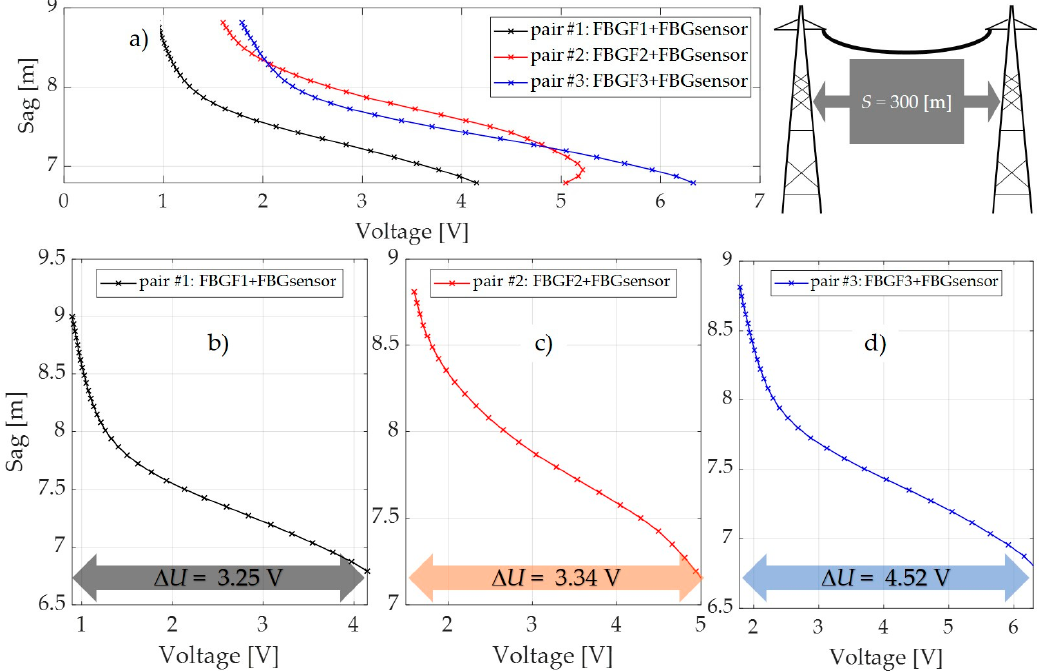
Figure 23. The results of the power line wire sag as a function of the photodetector measured voltages for power line # 3: ( a ) the sag characteristics for three pairs of FBG structures; ( b ) sag dependence on the photodetector measured voltage for pair #1; ( c ) sag dependence on the photodetector measured voltage for pair #2; ( d ) sag dependence on the photodetector measured voltage for pair #3.